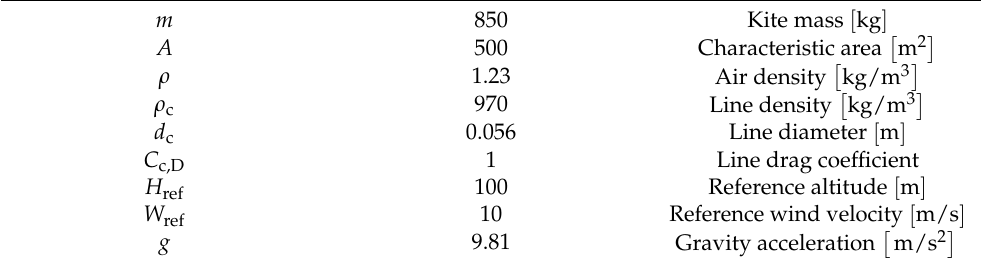
Table 2. Parafoil model parameters.